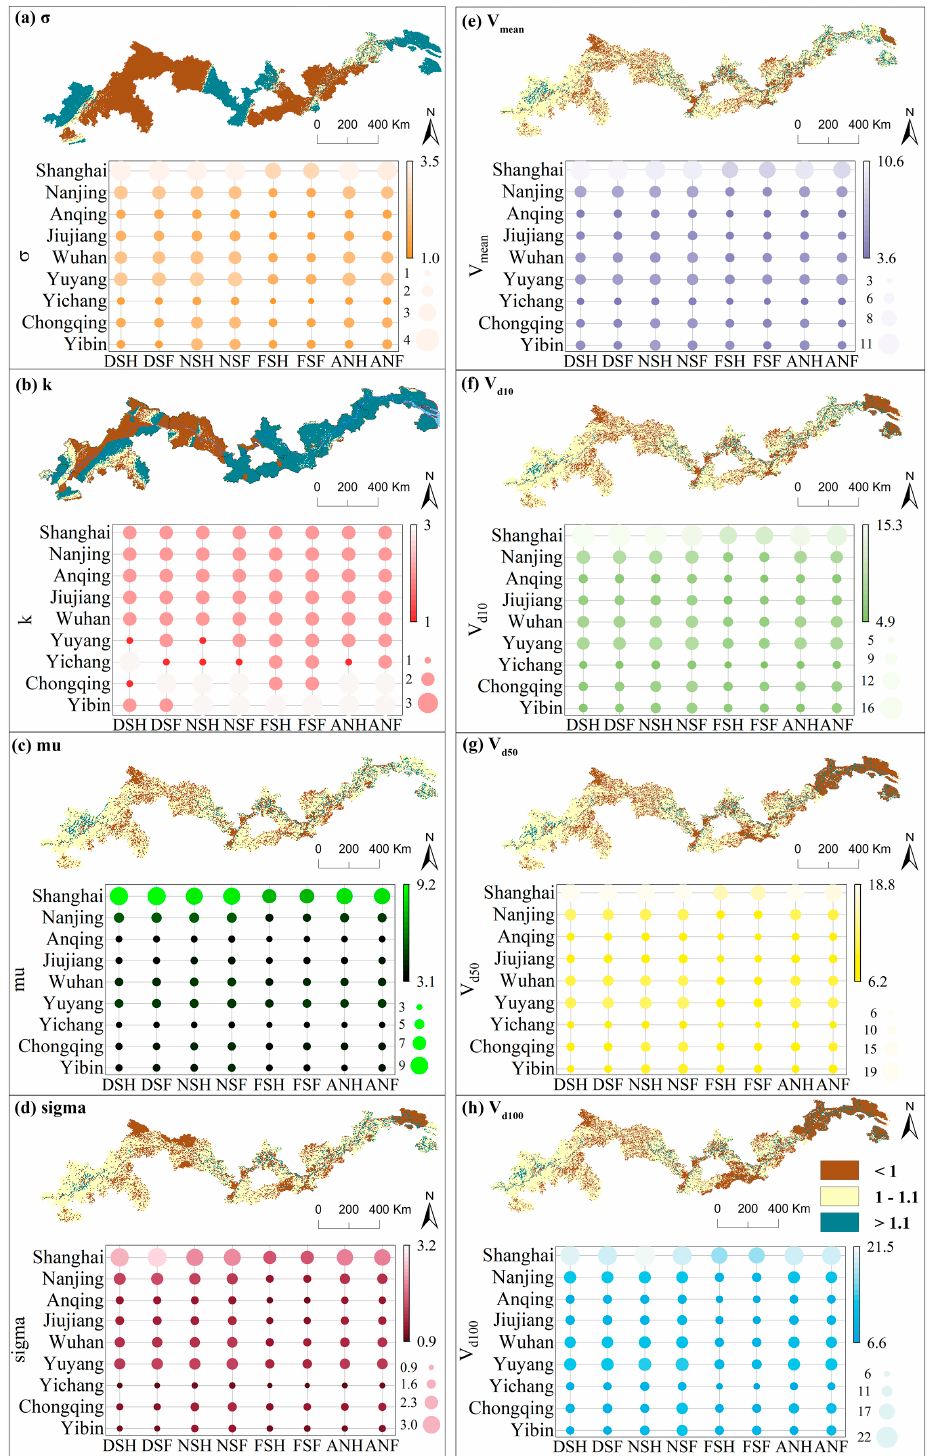
Figure 9. The spatial distribution of the dependent variables σ ( a ), k ( b ), mu ( c ), sigma ( d ), V mean ( e ), V d 10 ( f ), V d 50 ( g ) and V d 100 ( h ) for historical and future periods (annual–seasonal scale); DSH/DSF = dry season in historical/future period, NSH/NSF = normal season in historical/future period, FSH/FSF = flood season in historical/future period and ANH/ANF = annual in historical/future period.